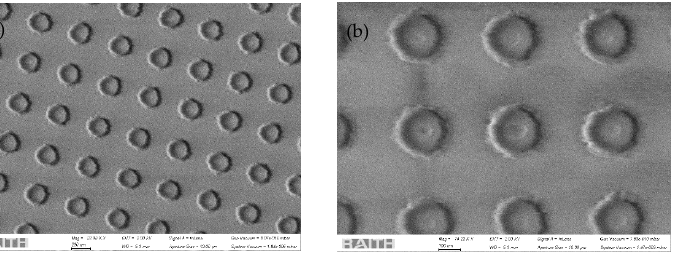
Figure 11. SEM image of cylinder NSs fabricated on a MM fiber tip. ( a ) An overview image of the cylinders array. ( b ) A detailed picture of the realized NSs.